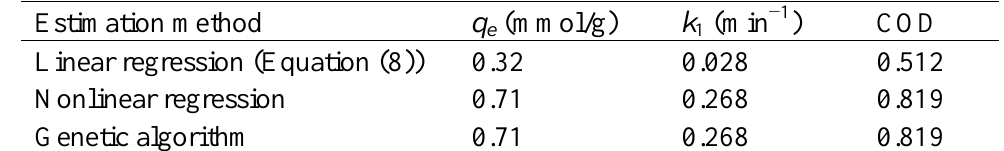
Table 4. Parameter estimation in the Lagergren equation by the linear regression, nonlinear regression and GA